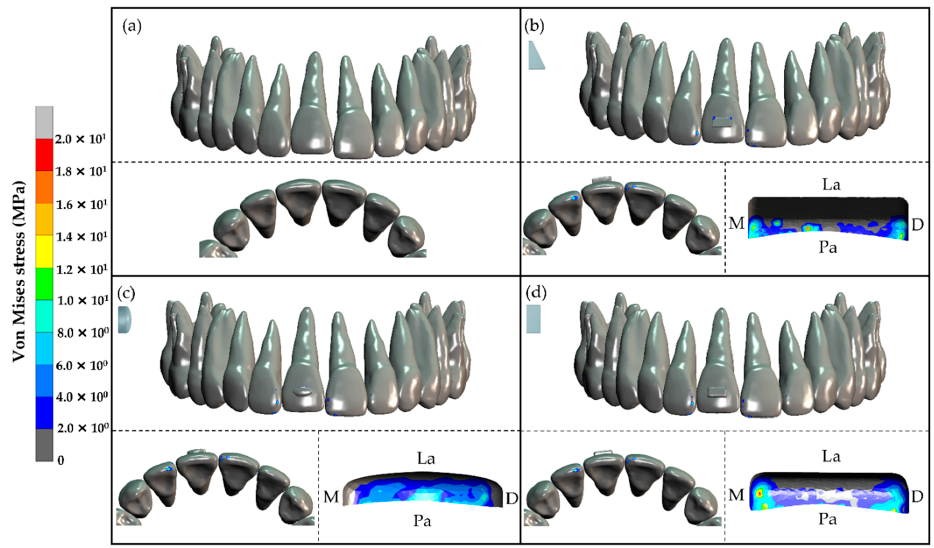
Figure 5. Distribution of von Mises stress on the upper anterior teeth in the frontal view, in- cisal view, and enlarged cervical view of the composite attachments: ( a ) no composite attachment, ( b ) rectangular beveled attachment, ( c ) ellipsoid attachment, and ( d ) horizontal rectangular attach- ment. M, Mesial; D, Distal; La, Labial; Pa,